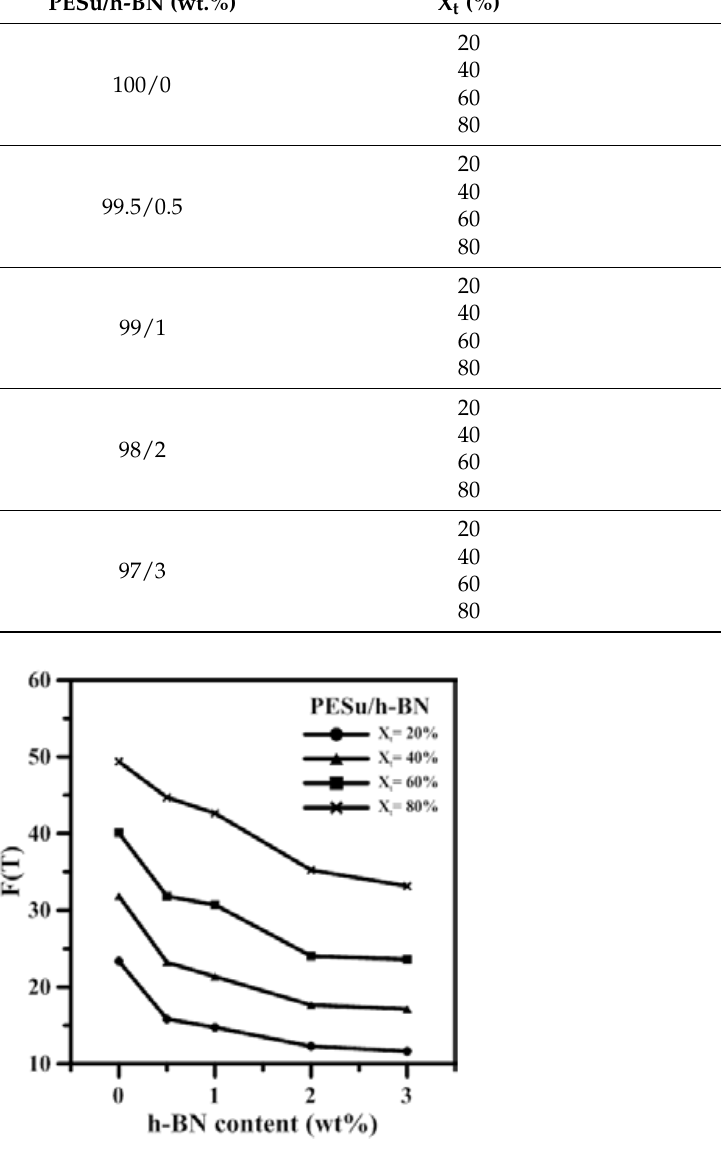
Figure 9. The F(T) values of PESu/h-BN composites that vary with h-BN content.